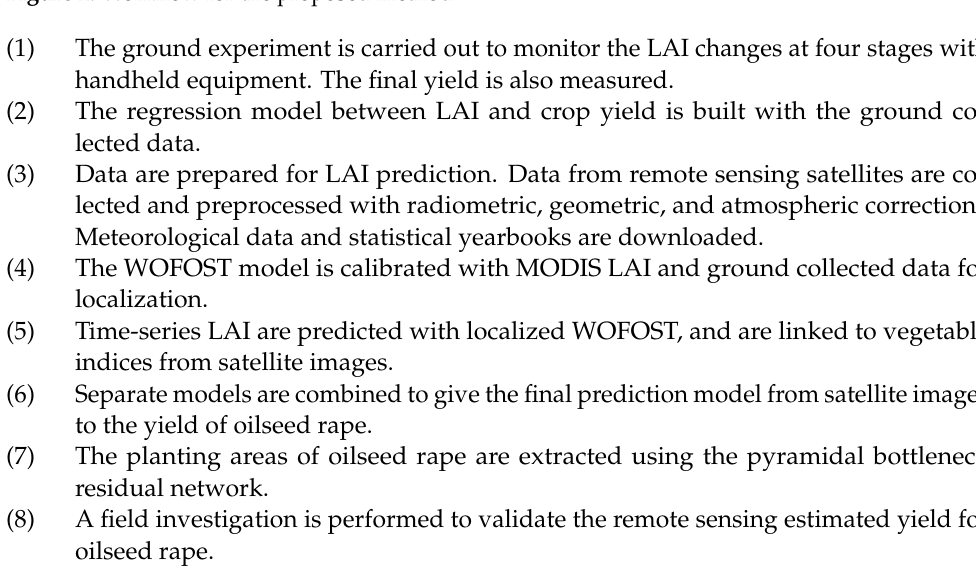
Figure 2. Workflow for the proposed